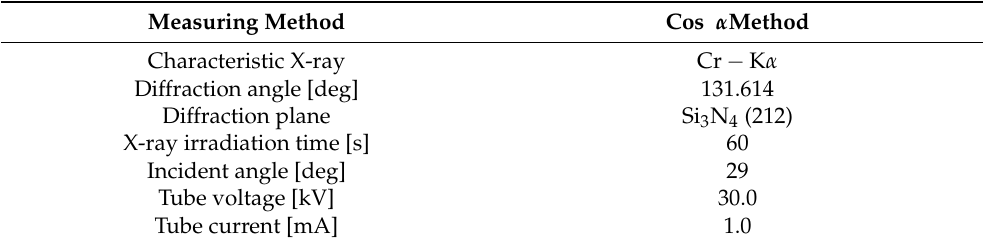
Table 2. Residual stress measurement